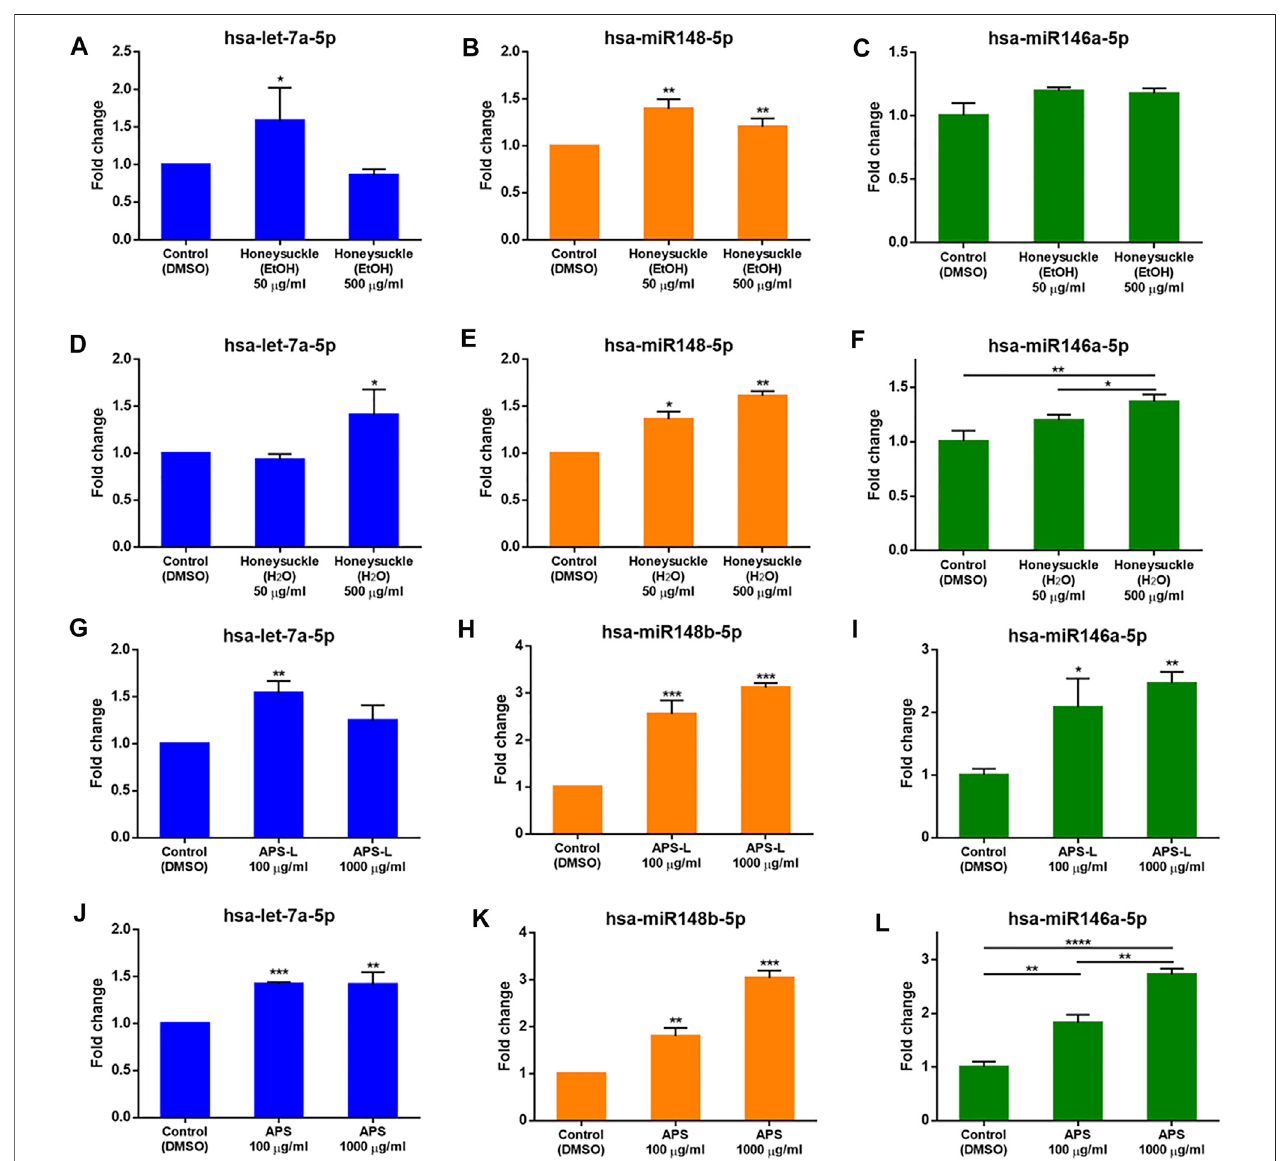
FIGURE4| Inductionof let-7a , miR-148b ,and miR-146a levelsbytheTCMcandidates. let-7a , miR-148b ,and miR-146a levelsweremeasuredbyqRT-PCRnormalizedto theinternalcontrolU54aftera24-htreatmentwithhoneysuckle-EtOH (A-C) ,honeysuckle-H2O (D-F) ,APS-L (G-I) ,andAPS (J-L) .Dataareexpressedasmean ± SDfromthree repeated results and analyzed using Student ’ s t-test. *, signi fi cantly different from the corresponding control, at p < 0.05; **, p < 0.01; ***, p < 0.001.